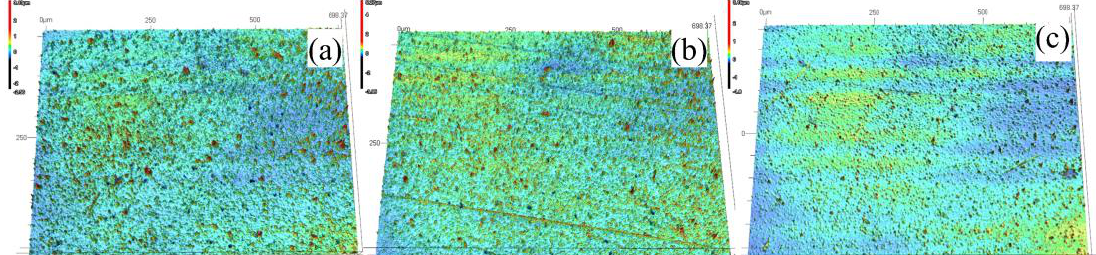
Figure 5. Roughness 3D diagram of Si-DLC with different transition layers: ( a ) AlTiSiN/Si-DLC; ( b ) AlCrN/Si-DLC; ( c )